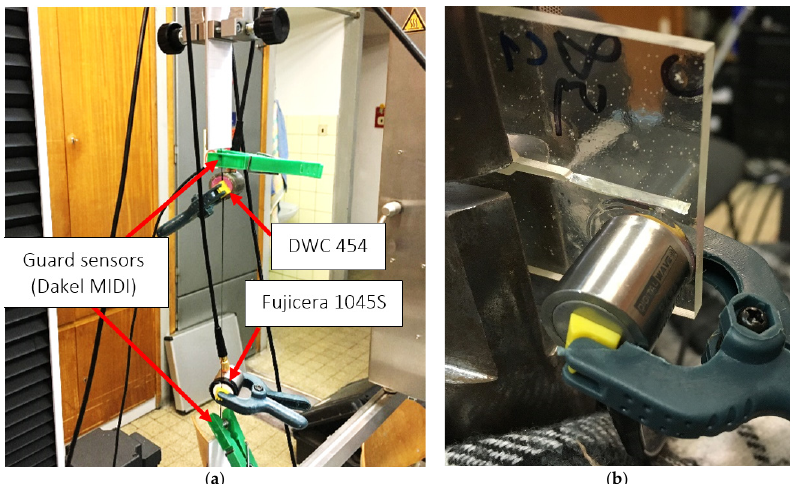
Figure 4. In situ photographs of the ( a ) tensile test of the carbon fibre bundle, ( b ) BRCT specimen, including the present unstable